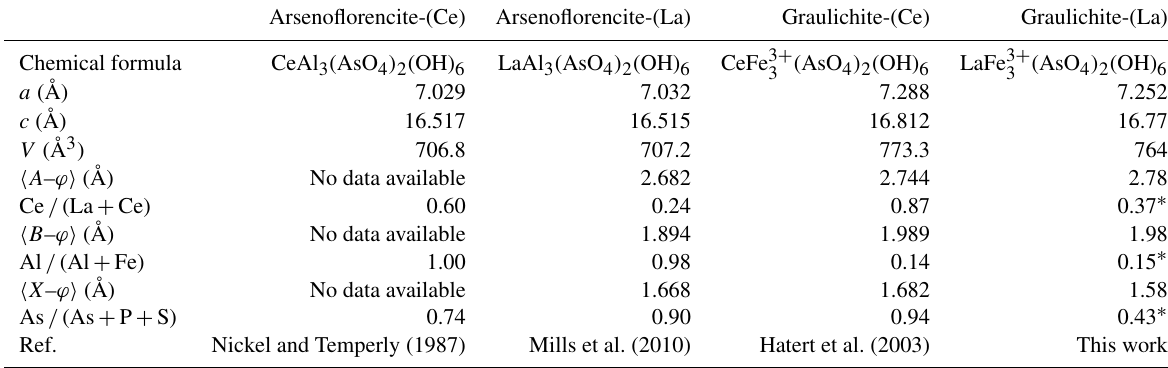
Data availability. The Crystallographic Information File data of graulichite-(La) are available in the